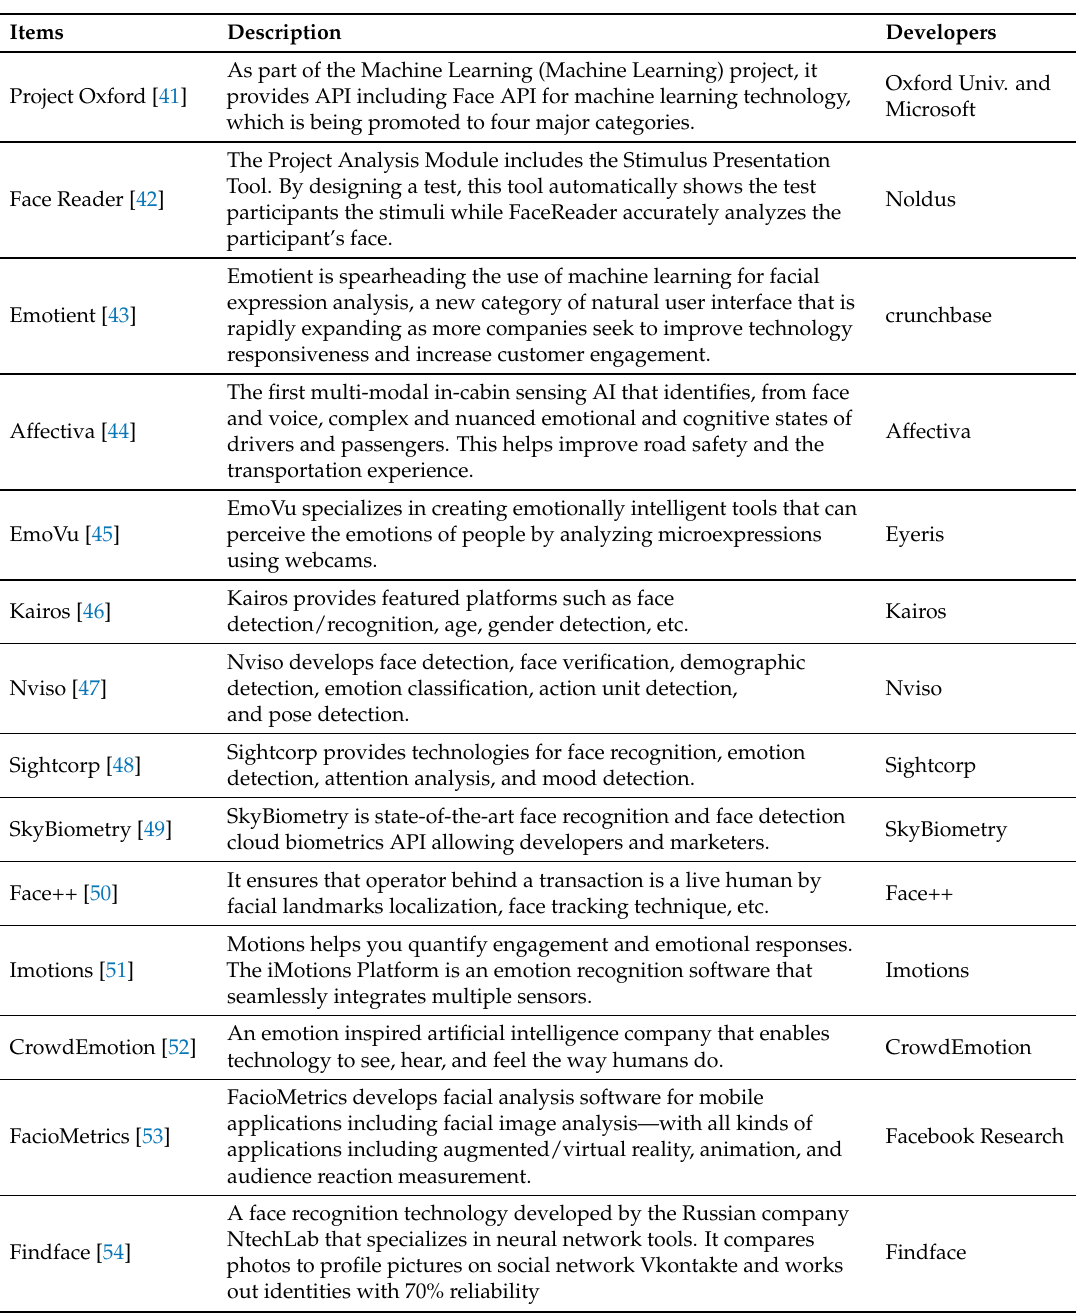
Table 1. Analysis of the existing FER systems for business